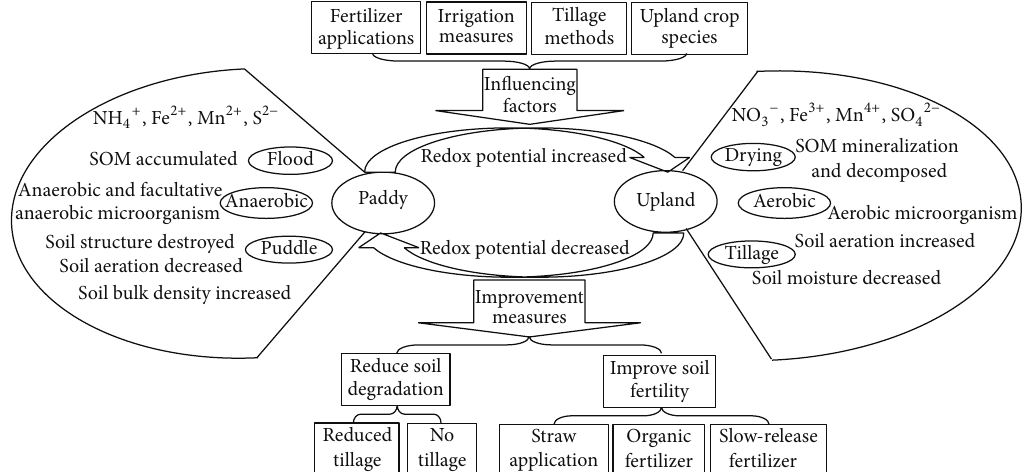
Figure 2: Characteristics of paddy-upland rotation and its improvement measures. SOM: soil organic